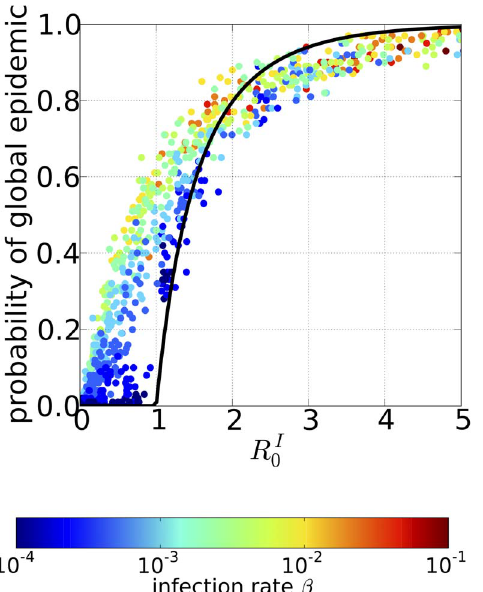
Figure 4. The probability of global epidemic as a function of the basic reproductive ratios in the initially infected home and work populations. The probability of a global epidemic observed in the individual-based model (IBM) simulations based on the commute network data for the Tokyo metropolitan area plotted as a function of ~ b ( N H z N W R I ) = c , where the independent variable is the sum of the i 0 j 0 0 Figure 5. The final size and the peak time of global epidemic. single population basic reproduction ratios of the initial home and work The final size of the global epidemic (A) and the time until an epidemic populations ( N H and N W : home and work population sizes of the initiated by a single host reaches its peak (B) plotted against the i 0 j 0 initially infected individual, respectively). Each point corresponds to a infection rate b . (A1) and (B1): results observed in the individual-based different set of epidemic parameters, and the color represents the model (IBM) simulations; each point gives the Monte Carlo ensemble infection rate b . Black line, the probability of a global epidemic in the average value corresponding to different epidemic parameters, and the z K single population model with population size K n color indicates the sum of the sizes of the initially infected home and m 0 , i.e., that from 0 (cid:8) P G ~ 1 { exp { P G R I work populations. Here, the cases for initial extinction of disease are 0 excluded from the ensemble. (A2) and (B2): corresponding results from the population size class model (PSCM)